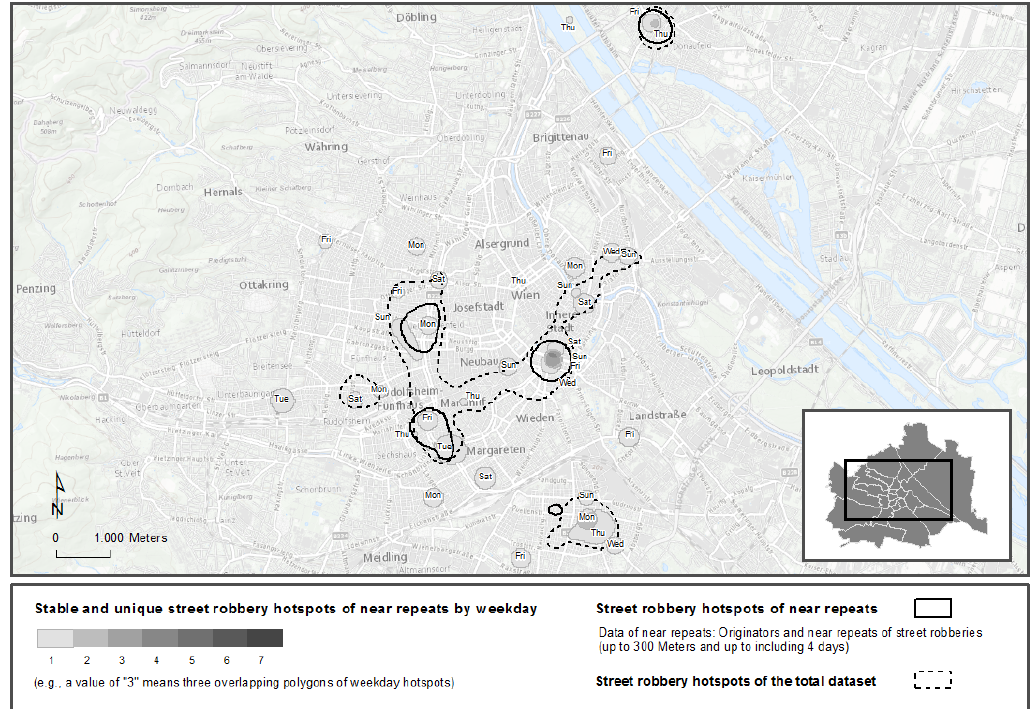
Figure 3. Street robbery hotspots of near-repeats from 6:00 a.m. to 1:59 p.m. by weekday.